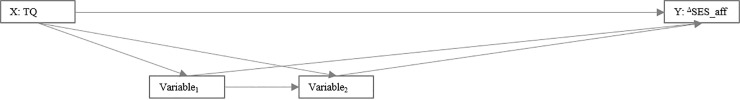
Indirect-effects models.TQ = tinnitus-related distress [Tinnitus Questionnaire (German version)—total score]; SES_aff = affective pain perception [Pain Perception Scale–subscale score]; X = independent variable; Y = dependent variable; Variables 1 and 2: alternate pairs of treatment-responsive process variables (depressivity [Center for Epidemiological Studies Depression Scale–total score or ICD-10 Symptom Rating–subscale score], emotional tension and worry [Perceived Stress Questionnaire–subscale scores]); t0 = pre treatment; t1 = post treatment; Δ = change score (t1 minus t0). Fig 1 illustrates the model specification that investigates if the relationship between baseline tinnitus-related distress and change in affective pain perception is associated with baseline values of psychological process variables.